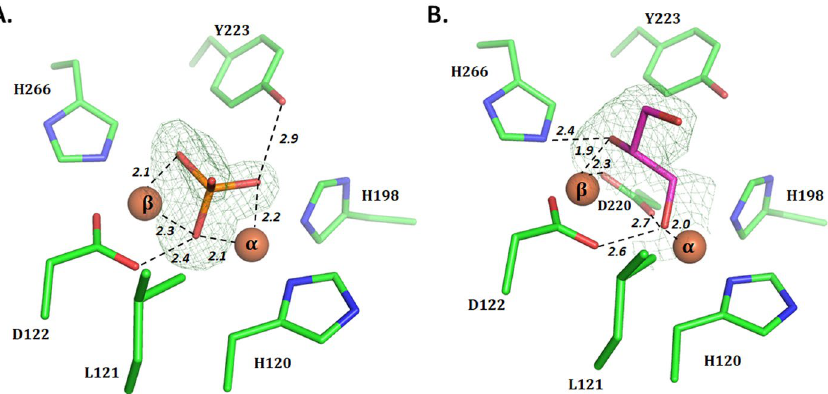
Figure 7. AaL active site in structures bound to phosphate and to glycerol. ( A ) Structure of AaL (green sticks) bound to phosphate (orange sticks) (PDB ID: 6CGY). 3 out of the 4 oxygen atoms of the phosphate molecule interact closely with the two metal cations α and β and as well as with D122 and Y223. ( B ) Structure of AaL (green sticks) bound to glycerol (pink sticks) (PDB ID: 6CHO). The glycerol molecule interacts with the bimetallic active site via two oxygen atoms. Fourier difference maps (F o -F c ) shown in green mesh are calculated by omitting the ligand from the model, and contoured at 5.0 σ ( A ) and 2.5 σ ( B )